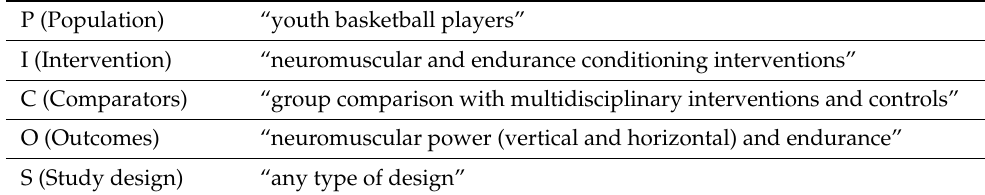
Table 1. PICOS model for inclusion criteria